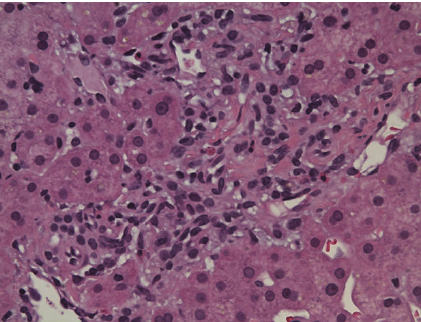
Figure 1: Representative portal area with few eosinophils but no evidence of interface hepatitis or bile duct injury.